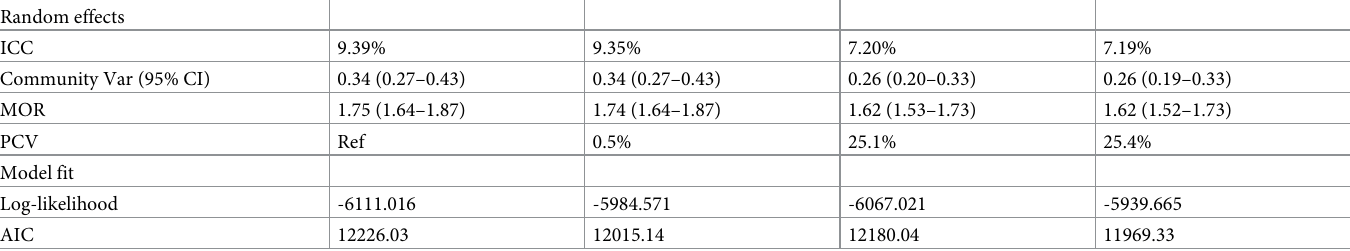
Table 3. Random effects of two-level logistic analysis of individual- and community level factors associated with total unmet need for family planning among mar- ried or in union women. Random